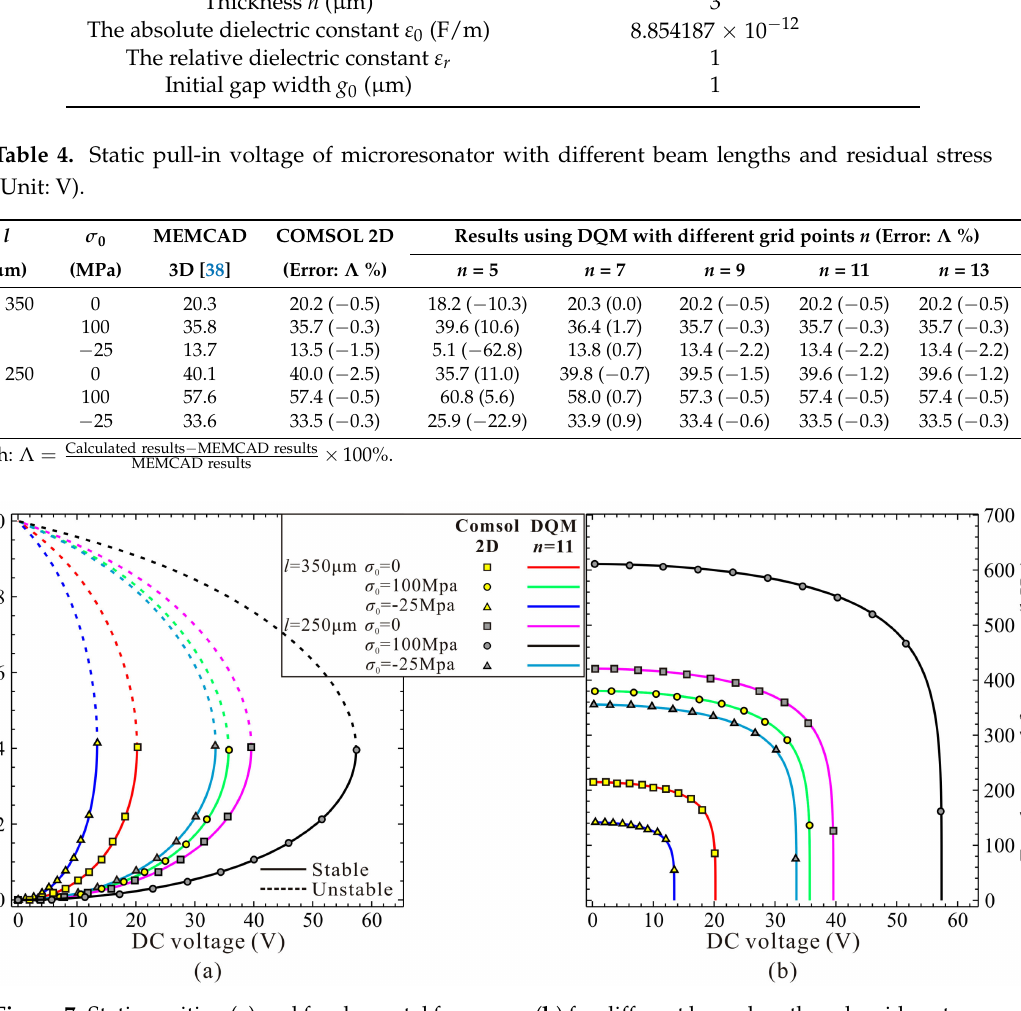
Figure 7. Static position ( a ) and fundamental frequency ( b ) for different beam length and residue stress. Table 5. A comparision between the experimental and calculated